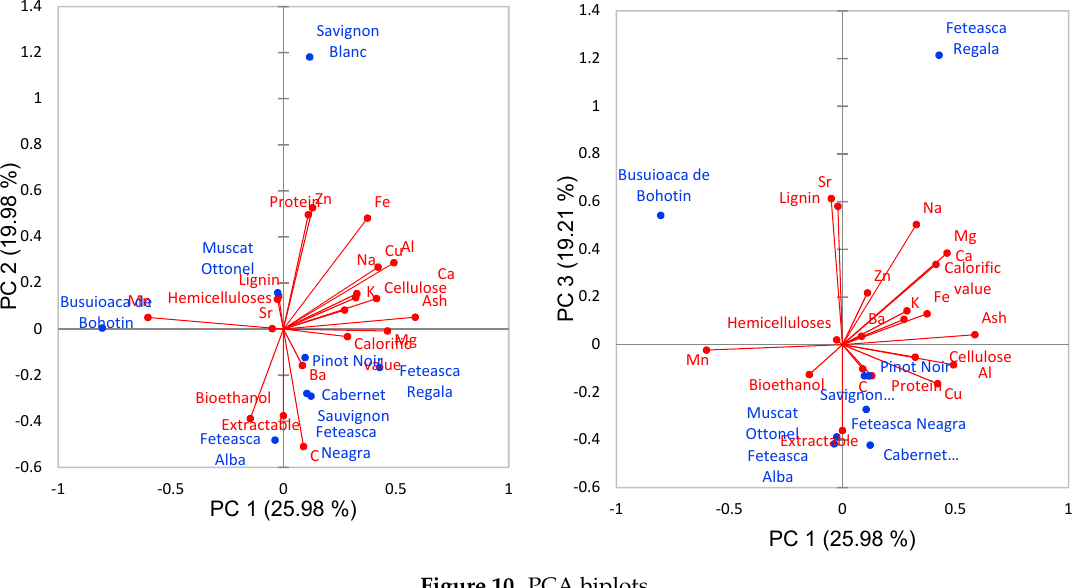
Figure 10. PCA biplots.